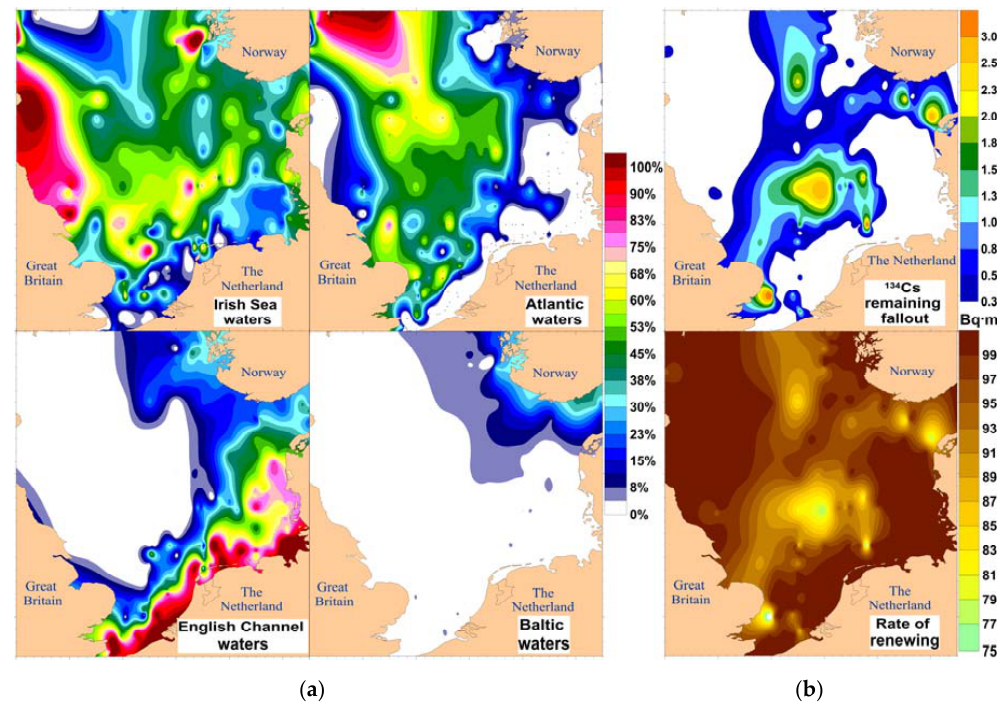
Figure 11. Percentage origins of water masses entering the North Sea in 1988 deduced from dissolved radionuclides measurements ( a ); 134 Cs remaining fallout from the Chernobyl accident and rate of renewing of water masses in two years ( b ), adapted from [17].